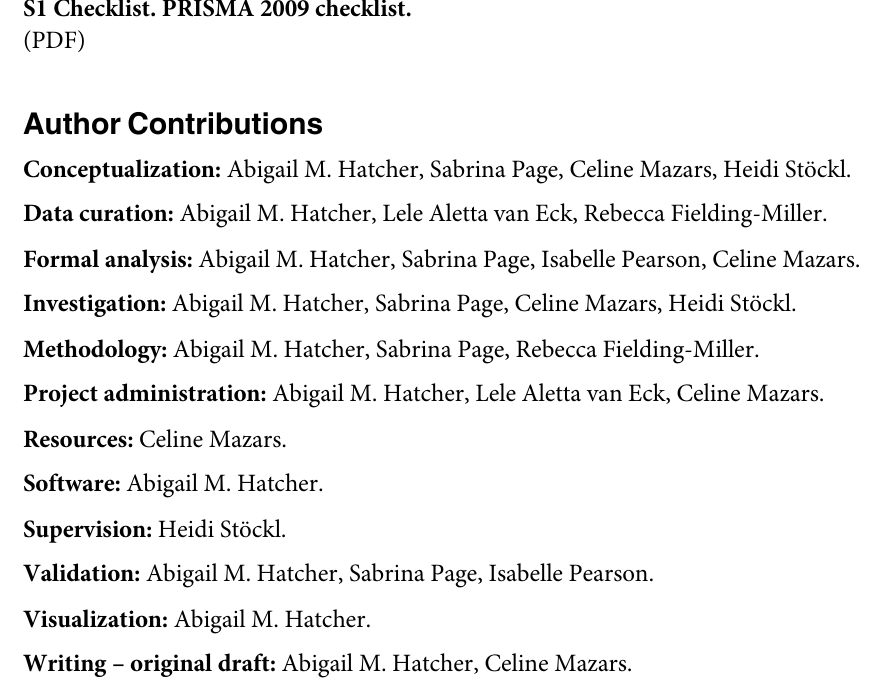
S1 Fig. Meta-analysis by sub-groups: Sex, VAWG type, region, study timeframe. (DOCX) S2 Fig. Funnel plot for publication